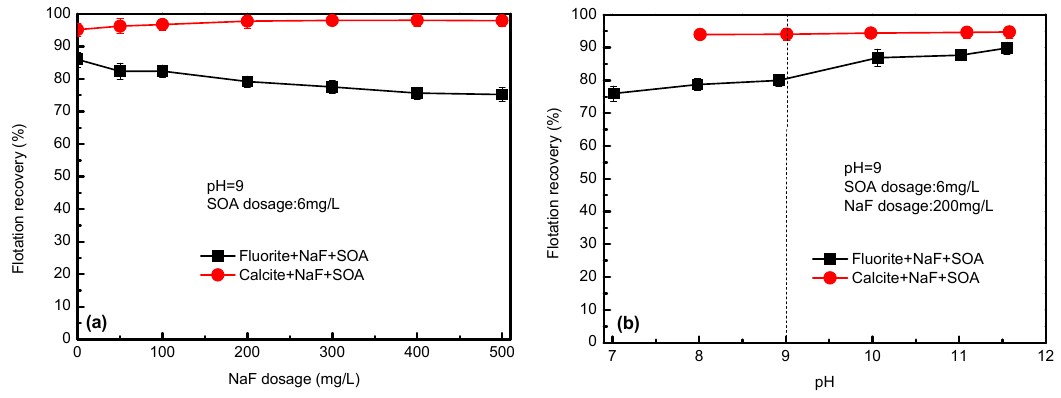
Figure 5. Effect of NaF dosage ( a ) and pH ( b ) on flotation recoveries of calcite and fluorite minerals using SOA as the collector and NaF as the depressant.